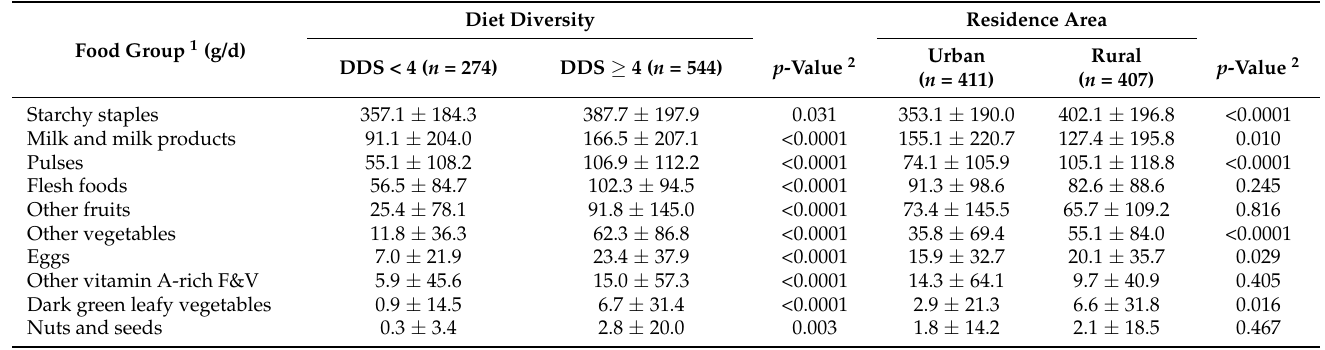
Table 3. Food group consumption of Costa Rican adolescents, according to Diet Diversity Score (DDS) and residence area.